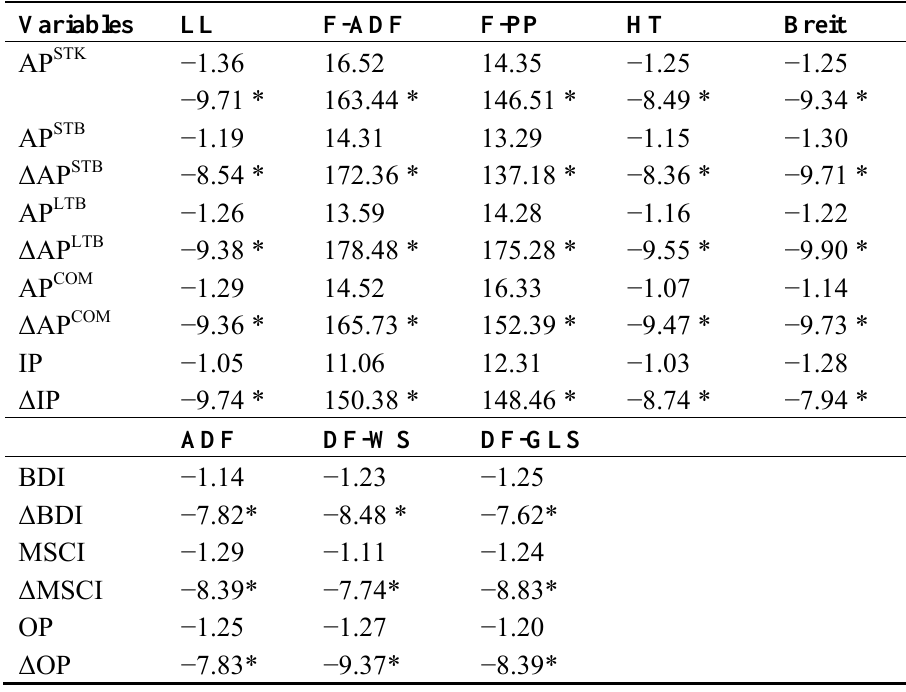
Table 1. Unit root